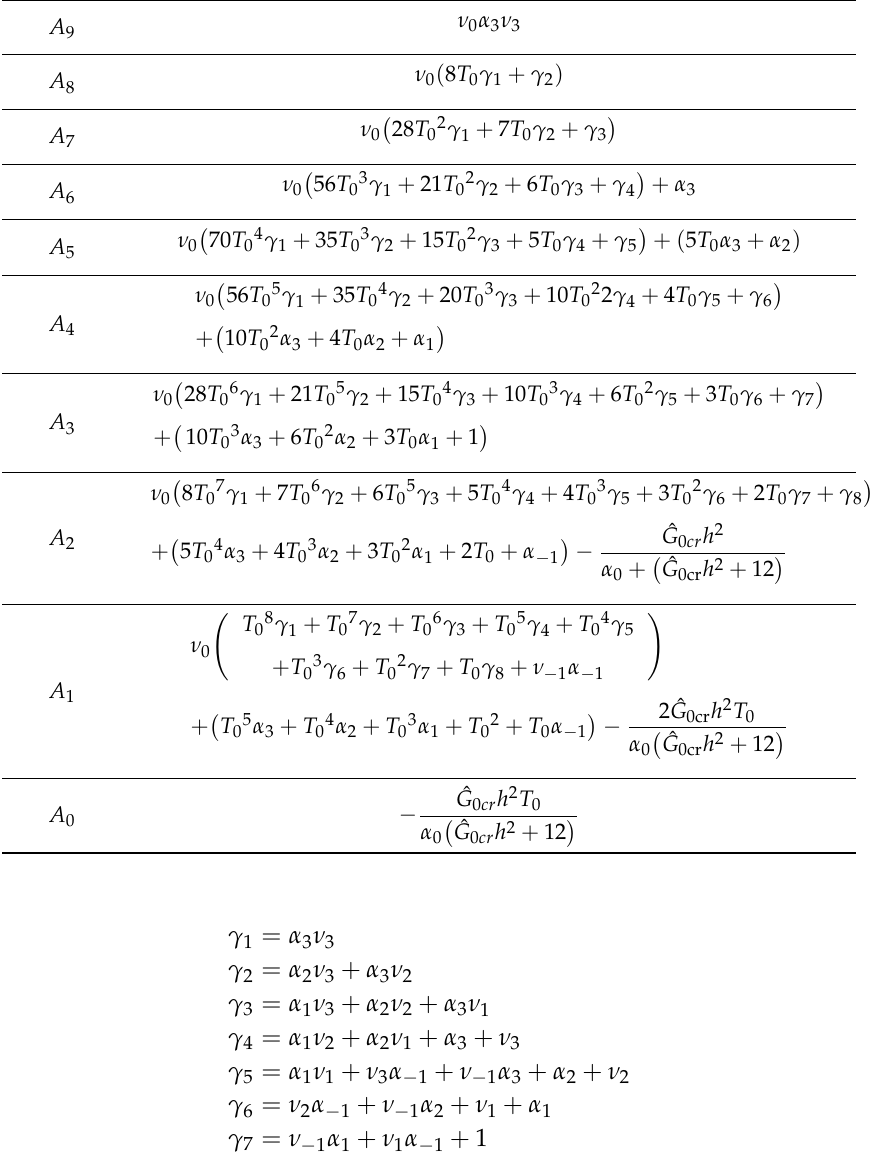
Table A1. Coefficients of Equation